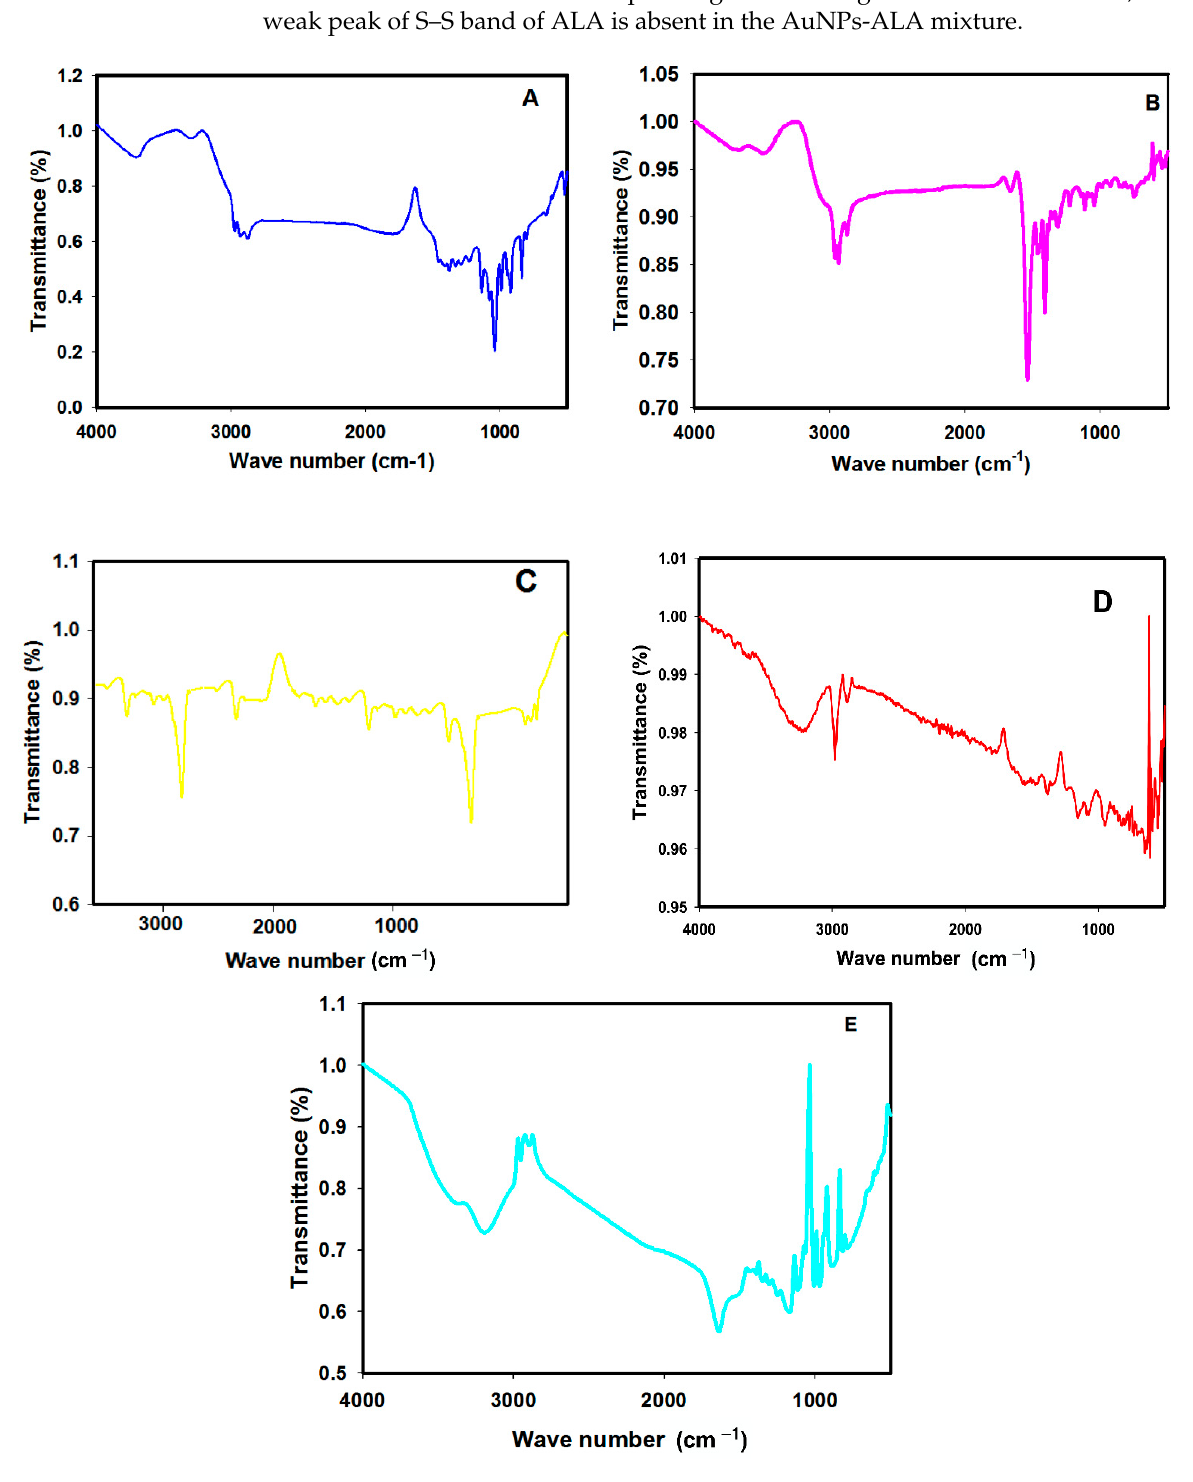
Figure 7. Fourier transform infrared spectroscopic spectra of ( A ) vehicle, ( B ) VPA, ( C ) ALA, ( D ) AuNPs, and ( E ) AuNPs-ALA.